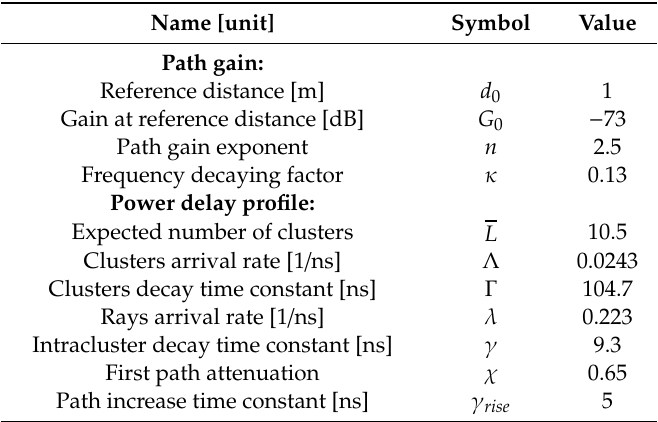
Table 2. The UWB channel parameters for outdoor NLOS